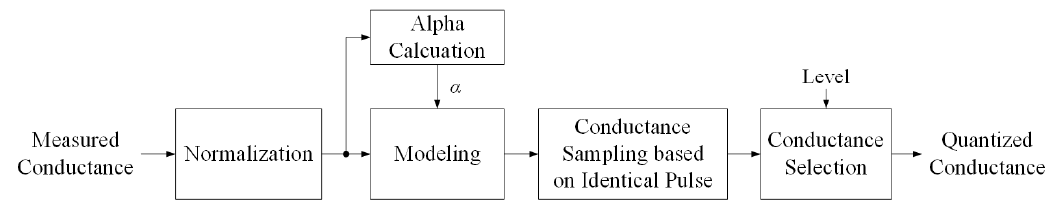
Figure 4. The proposed process of converting the measured conductance into the quantized conductance; after applying the modeling function to the normalized conductance, the conductance is sampled based on the identical pulse. Next, the conductance that maximizes linearity according to the level is selected, and the quantized conductance is extracted.